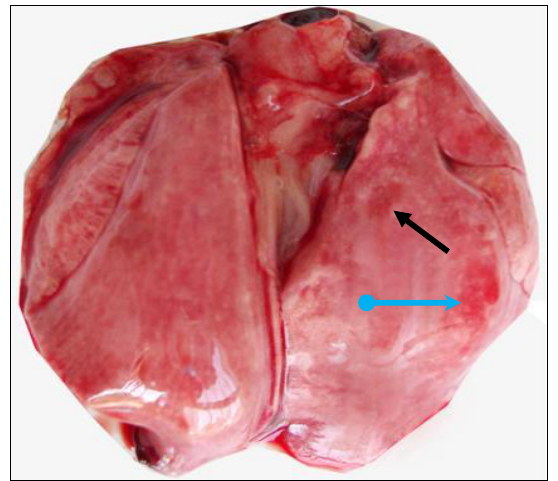
Fig:2 Gross rabbit liver of 2nd immunized group at 20 days post challenge show moderate enlargement with lobular pattern on its surface.